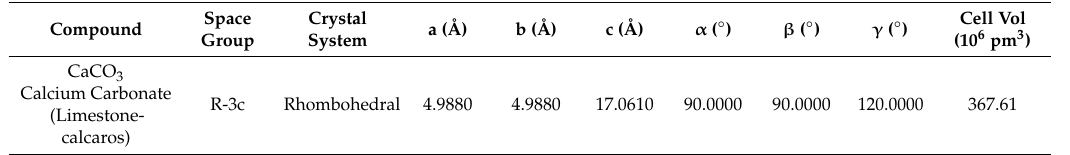
Table 8. Lattice parameters of CaCO